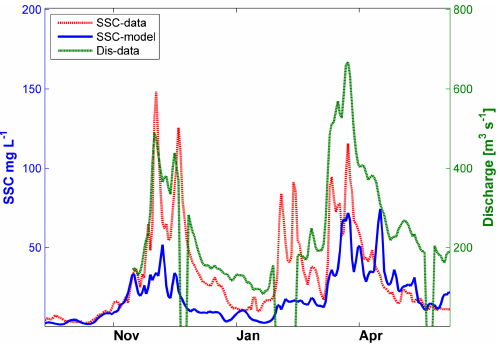
Figure B2. Water discharge (model) and SSC level (data and model) in MOK